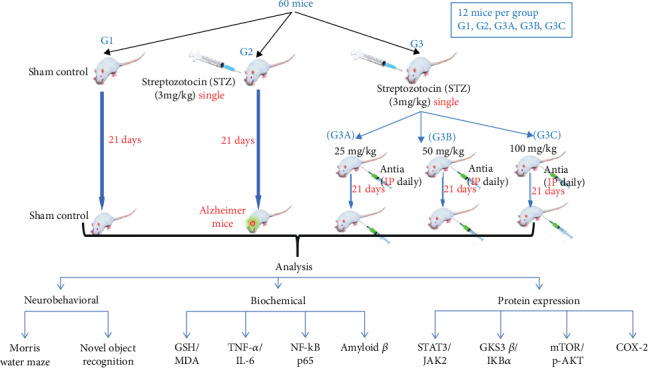
Experimental design.